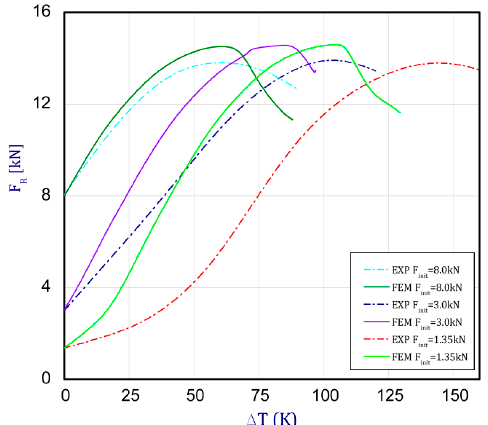
Figure 8. The force reaction vs. the temperature increment for different preloads obtained by EXP.